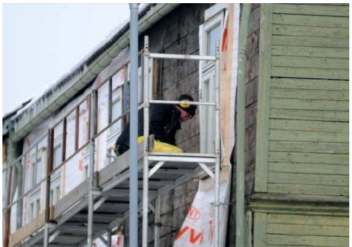
Figure 8. Renovation of the façade (Trondheim Municipality, 2016).